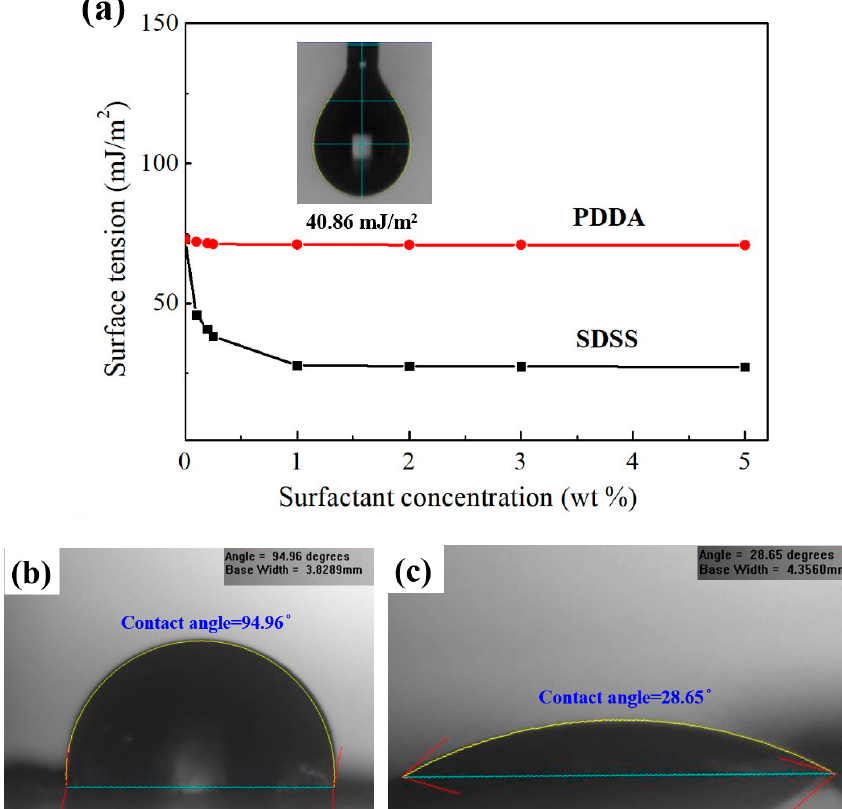
Figure 6. ( a ) Effect of surfactant concentrations on the surface tension of deionized water. The inset shows that a surface tension of 40.86 mJ/m 2 was obtained from the pendant drop shape analysis when the addition ratio was 1 wt% PDDA + 0.05 wt% SDSS. Contact angle measurement ( b ) with a deionized water droplet, ( c ) with a dispersant droplet on the carbon nanomaterial film. A number of solutions containing different surfactants were formulated and applied to the carbon nanomaterial suspensions for a sedimentation comparison, including 0.2 wt% SDSS (40.8 mJ/m 2 ), 1 wt% PDDA (71 mJ/m 2 ), 1 wt% PDDA + 0.05 wt% SDSS (40.86 mJ/m 2 ) and 1 wt% SDBS (41 mJ/m 2 ) solutions. The concentration of the carbon